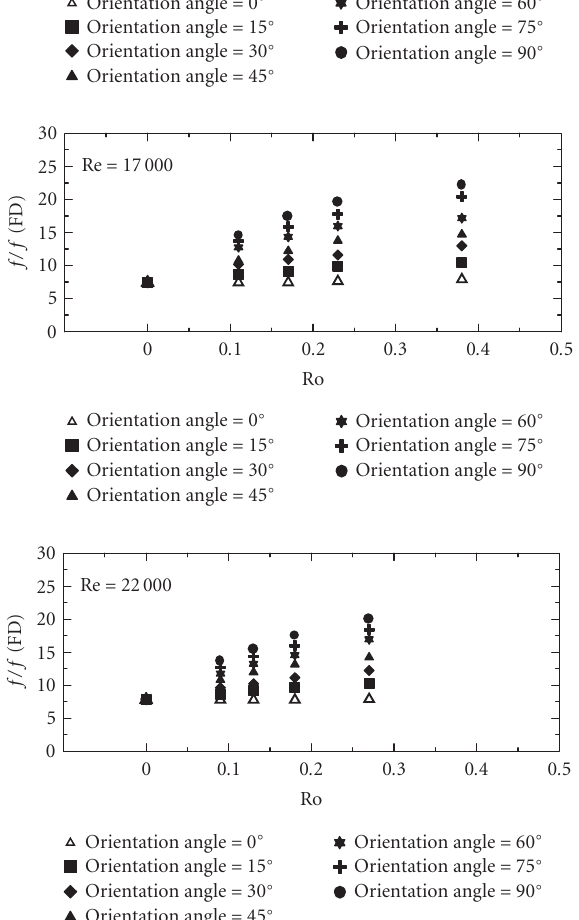
successive ribs for the 0 ◦ orientation case for stationary and rotating conditions. The pressure at di ff erent axial locations for the same spanwise location showing nearly identical val- ues for the no-rotation case is expected. The small di ff er- ence in slope between the first and last two axial locations is indicative of the existence of a separation zone in between the ribs. The pressure distribution in between the ribs for the situation with rotation can be noticed to be di ff